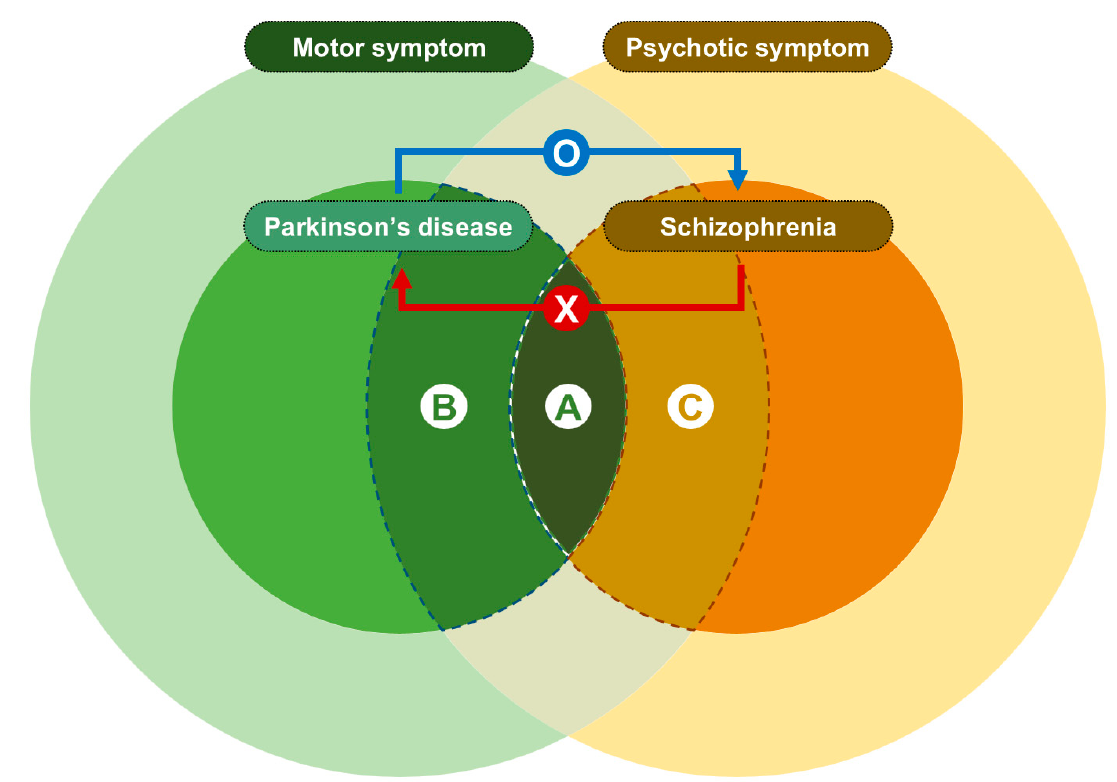
Figure 3. Schematic illustration of the association between Parkinson’s disease and schizophrenia from two-sample Mendelian randomization. The blue arrow indicates the direction of causal relationship between Parkinson’s disease and schizophrenia. The red arrow indicates an insignificant causal relationship between in reverse direction.